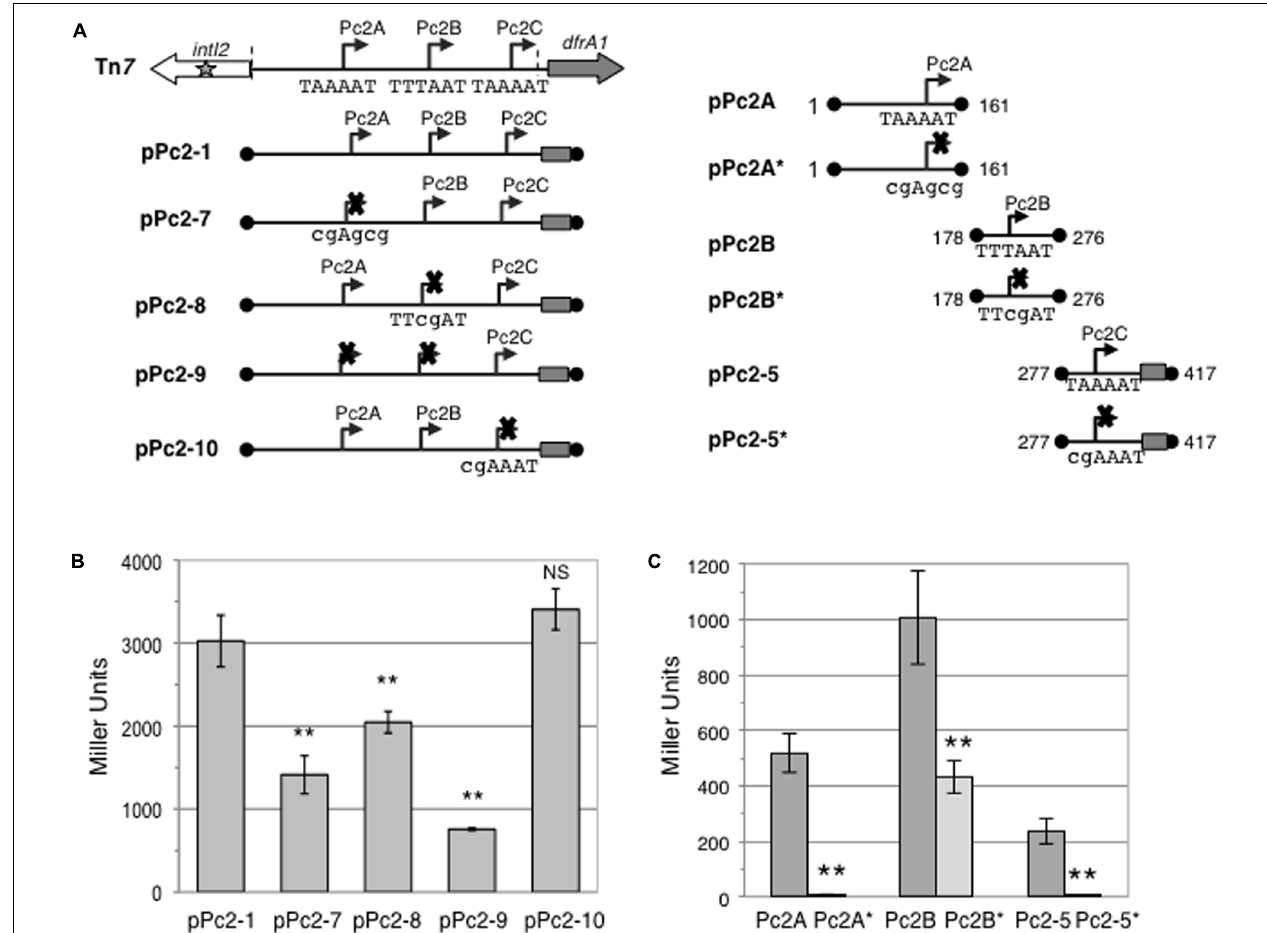
FIGURE 4 | Specific contributions of the Pc2A, Pc2B and Pc2C promoters. (A) Schematic representation of the class 2 integron carried on Tn 7 , Pc- lacZ translational fusions with the entire or partially deleted attI2 site carrying functional or mutated Pc promoters carried on pPc2-1, pPc2-7 to pPc2-10 and pPc2-5 and pPc2-5 ∗ ; and Pc- lacZ transcriptional fusions with WT or mutated Pc2A and Pc2B carried on plasmids pPc2A, pPc2A ∗ , pPc2B and pPc2B ∗ , respectively. Inactivating mutation of a promoter -10 sequence is indicated by a cross. The wild type and mutated -10 sequences are written under the promoters with mutated residues shown in lowercases. Boundaries of the cloned fragment are indicated by black dots and numbered as in Figure 1B . The cloned portion of the dfrA1 coding sequence is indicated by a rectangle. Broken arrows represent each Pc2 promoter, and their coordinates (1st base of its -35 element and last base of its -10 element) are indicated for individually cloned promoters. (B) The contribution of promoters Pc2A, Pc2B and Pc2C within attI2 was estimated by measuring β -galactosidase activity from constructs carrying one or several inactivated promoters. (C) Individual promoter strength was estimated by measuring β -galactosidase activity. At least five independent assays were performed for each construct. Error bars indicate the standard deviation. P -values (ANOVA and HSD Tukey’s test) for comparisons with pPc2-1 (B) or with the respective WT promoter (C) are indicated: ∗∗ p < 0.01, NS p >